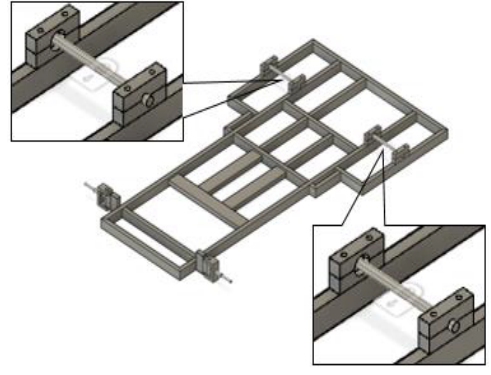
Figure 9: Structural constraints in the design of SEM urban